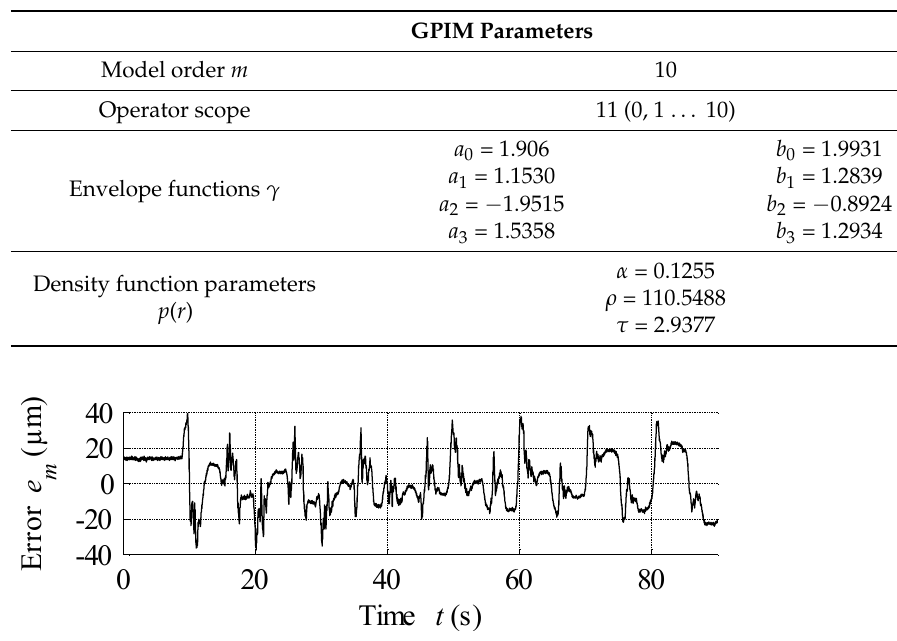
Table 2. Estimated GPIM parameters.